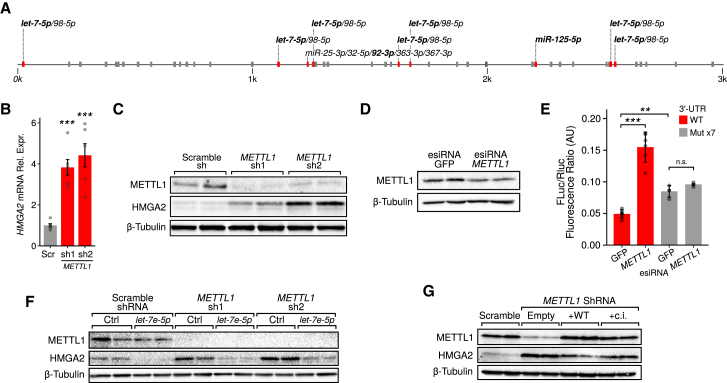
METTL1 Catalytic Activity Regulates HMGA2 Expression in a let-7-Dependent Manner(A) Schematic of HMGA2 3′ UTR showing the enrichment of evolutionarily conserved target sites of several m7G-containing miRNAs (OR = 5.46, p = 0.001).(B) HMGA2 expression was measured by qRT-PCR in A549 cells infected with METTL1-specific (sh1, sh2) or control (Scr) TET-inducible shRNAs 5 days after doxycycline treatment. The average of six biological replicates ± SDs is shown (∗∗∗p < 0.001, two-tailed t test).(C) Western blot showing METTL1, HMGA2, and β-tubulin protein levels in A549 cells infected with METTL1-specific (sh1, sh2) or control (Scramble) TET-inducible shRNAs 5 days after doxycycline treatment. Two representative biological replicates of a total of four are shown.(D) Western blot showing METTL1 downregulation upon transfection with METTL1-specific siRNAs in A549 cells stably expressing a luciferase cDNA with Hmga2 3′ UTR. Two independent transfections of a total of four replicates are shown.(E) Luciferase fluorescence levels upon METTL1 downregulation in A549 cells stably expressing a luciferase cDNA with Hmga2 3′ UTR as a reporter. Red and gray bars indicate luciferase levels in the presence of either WT Hmga2 3′ UTR or of a variant in which all 7 let-7 seed sequences have been mutated, respectively. The plot shows the average of four independent transfections ± SDs (∗∗∗p < 0.001, two-tailed t test).(F) Western blot showing the rescue of HMGA2 upregulation upon transfection with let-7e-5p mature miRNA in METTL1 knockdown A549 cells. Two independent transfection replicates of a total of four are shown.(G) Western blot showing the rescue of HMGA2 upregulation upon the overexpression of WT, but not catalytically inactive METTL1, in A549 METTL1 knockdown cells. Two representative biological replicates of a total of five independent infections are shown.See also Figure S4.